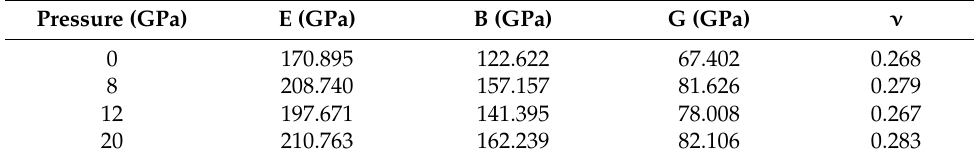
Table 3. Calculated independent elastic constants (all in GPa) of U 3 Si 2 C 2 .